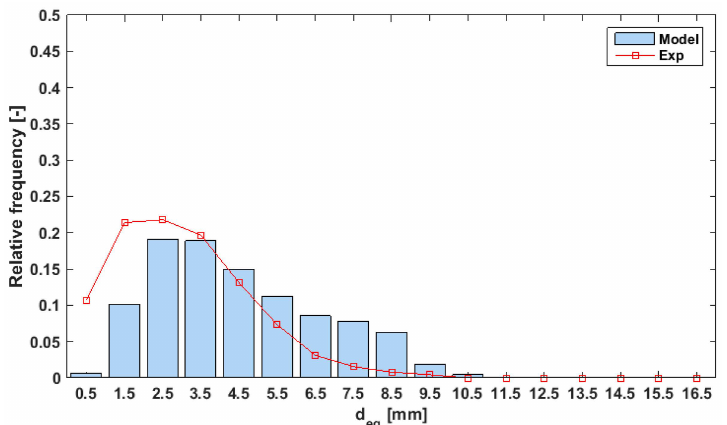
Figure 17. Comparison between PBM results and experimental data: Martinez constant and uniform BSD at the inlet: U G = 0.0188